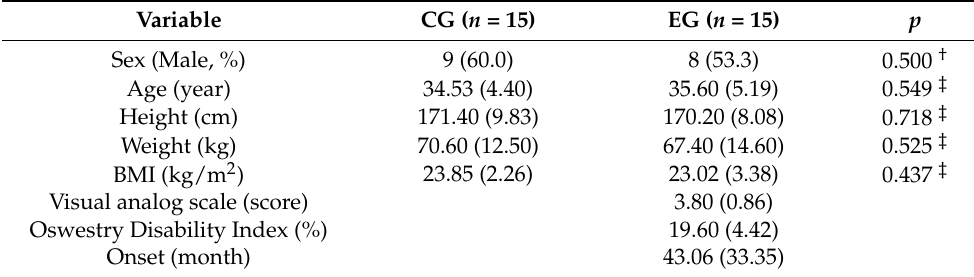
Table 1. General characteristics of the experimental and control